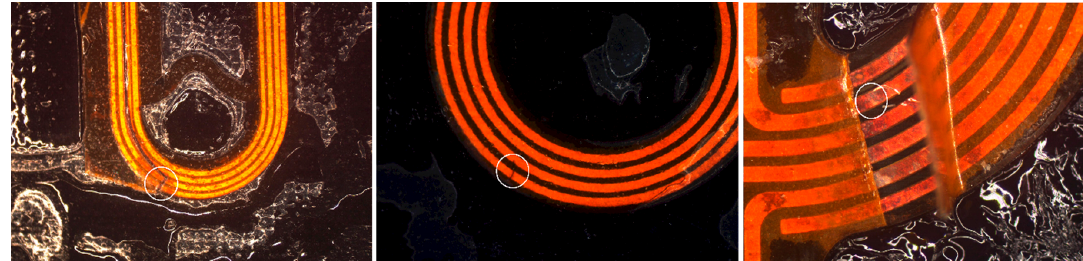
Figure 11. Typical cracks in samples after washing tests. From left: sample 10, 14 and 32.